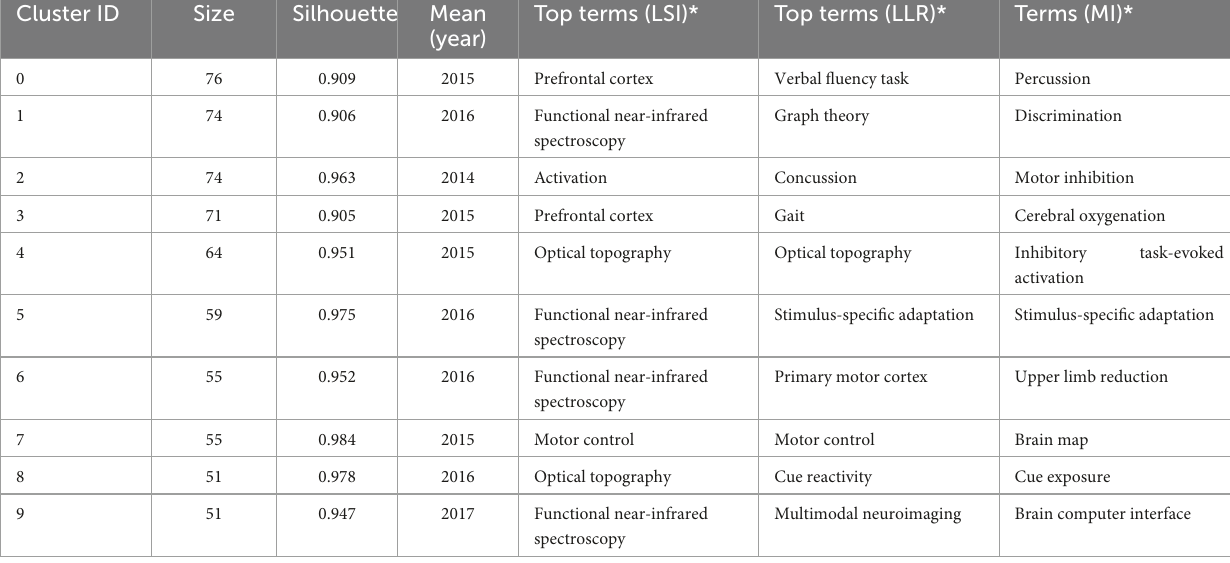
TABLE 3 The list of main keyword clusters.